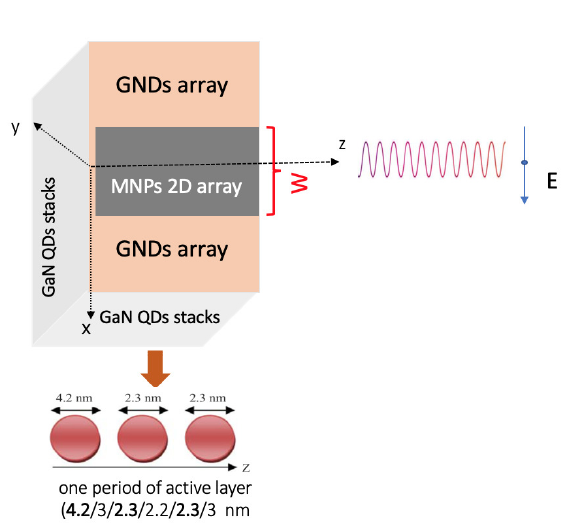
Figure 1. Schematic illustration of the proposed metal nanoparticle (MNP)-graphene nanodisk (GND)-quantum dots (QD)-based